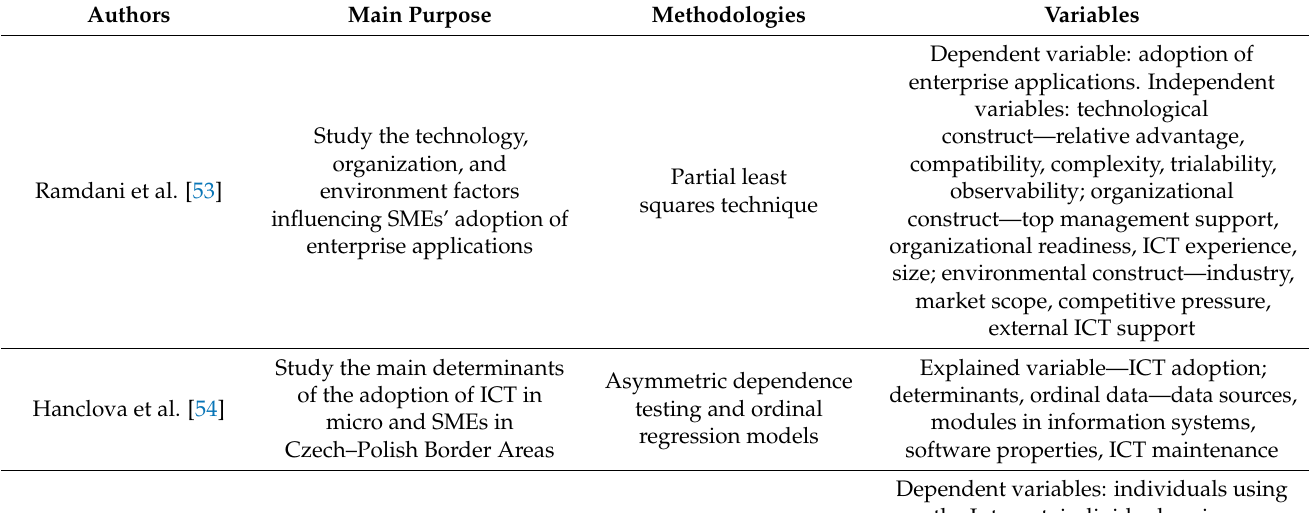
Table 1. Studies on the assessment of the factors that influence ICT adoption in EU